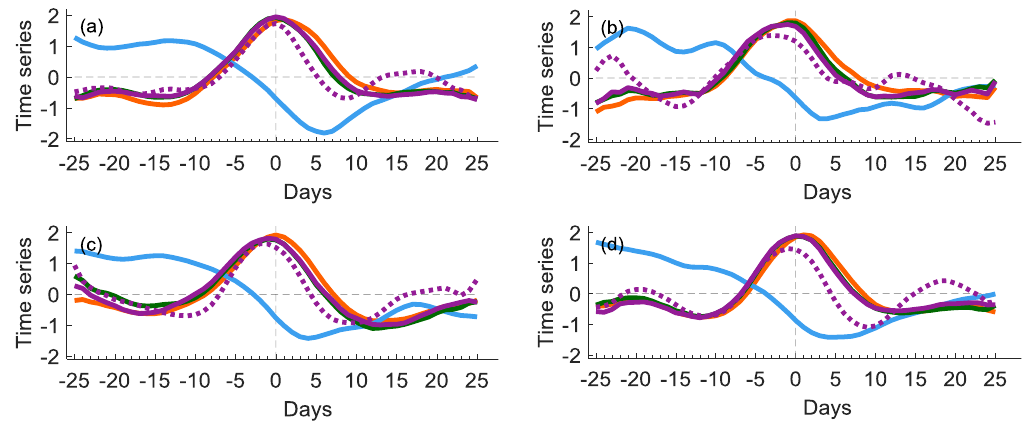
Figure 8. Standardized time series of the composite regional averaged SIC (blue lines), SAT (orange lines), PWA (green lines), downward IR (purple lines) and 850−hPa horizontal temperature advection (dashed purple lines) anomaly from lag −25 to lag 25 of blocking events for ( a ) GB, ( b ) UB, ( c ) PB−W and ( d ) PB−E events. The averaged regions are Baffin Bay, Barents-Kara Seas, Okhotsk Sea and Bering Sea for ( a – d ), respectively.